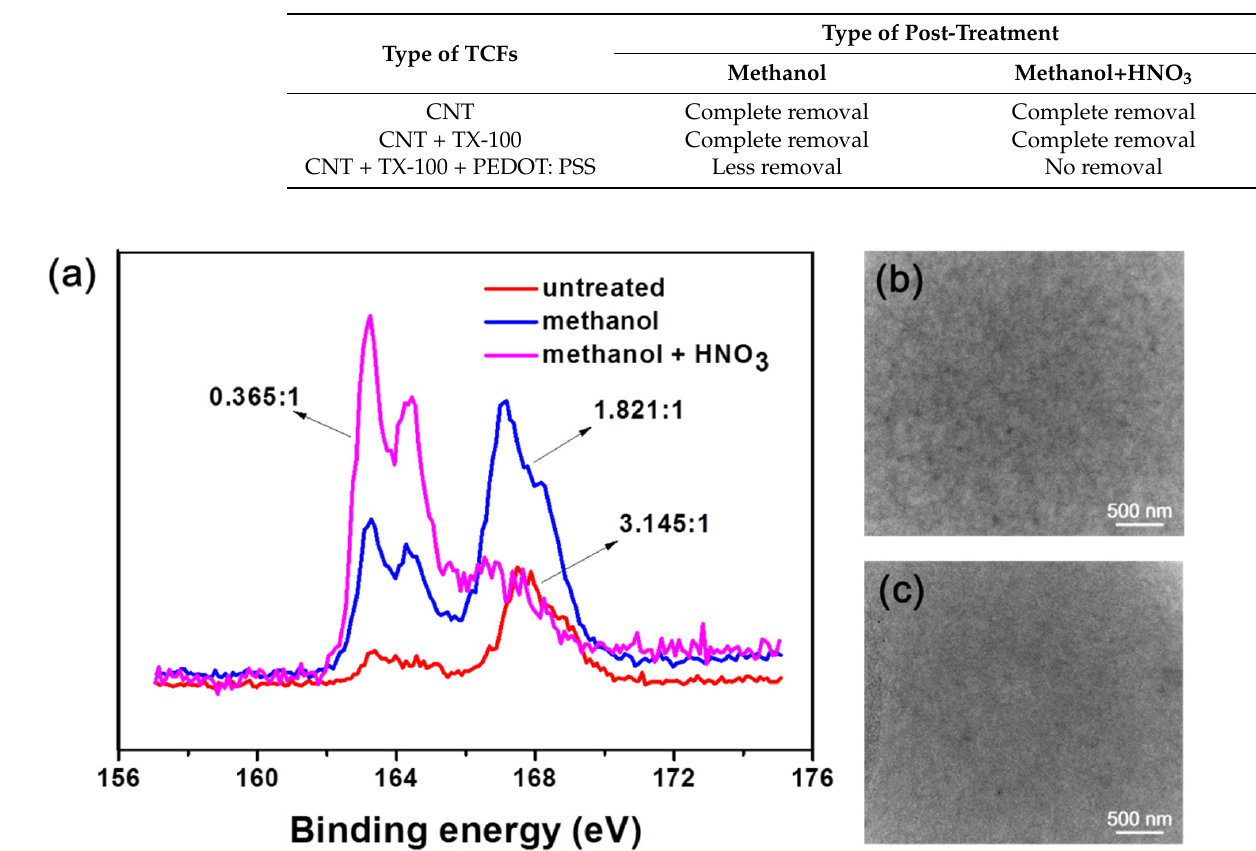
Figure 4. ( a ) XPS spectra of S1s element for PEDOT: PSS films made using different post processing methods (the indicated ratios correspond to PSS: PEDOT, calculated from the spectral area). TEM images of ( b ) P-TCFs and ( c ) P-NTCFs.